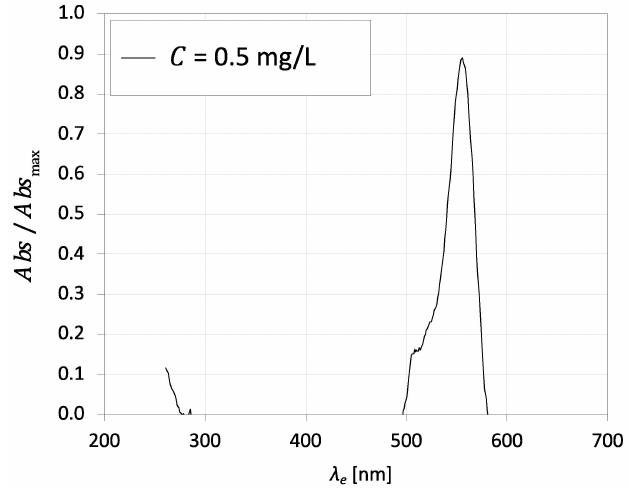
Figure 9. Absorption spectra of RhB for an excitation wavelength from 200 to 700 nm for 0.5 mg · L − 1 at 20 ◦